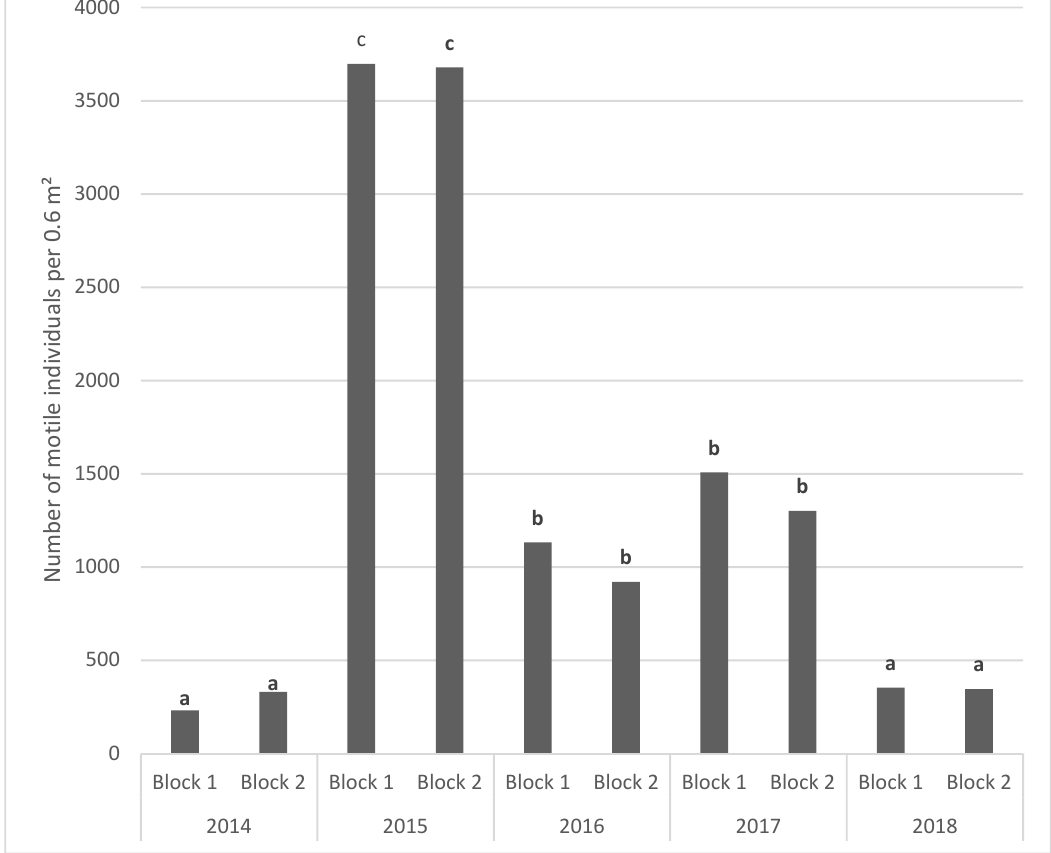
Figure 7. Abundance of the motile fauna per 0.6 m 2 in the ten blocks sampled from 2014 to 2018, with results of the Tukey tests (superscript: same letters in adjacent columns indicate no significant statistical difference between blocks and years).